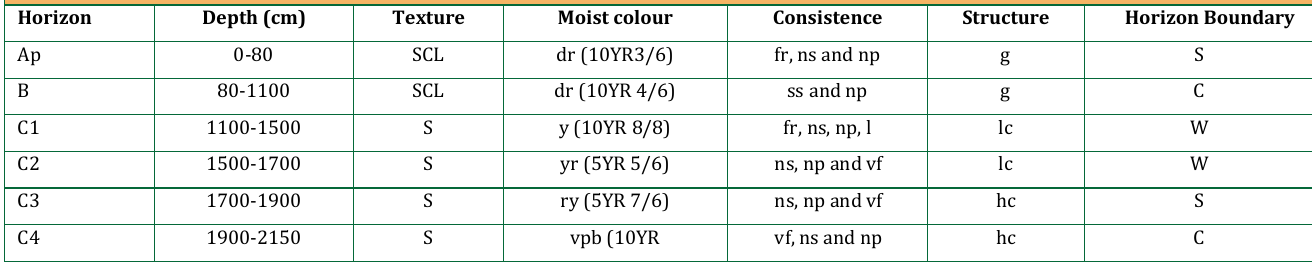
Table 2: Morphological features of the Horizons within the profile pit